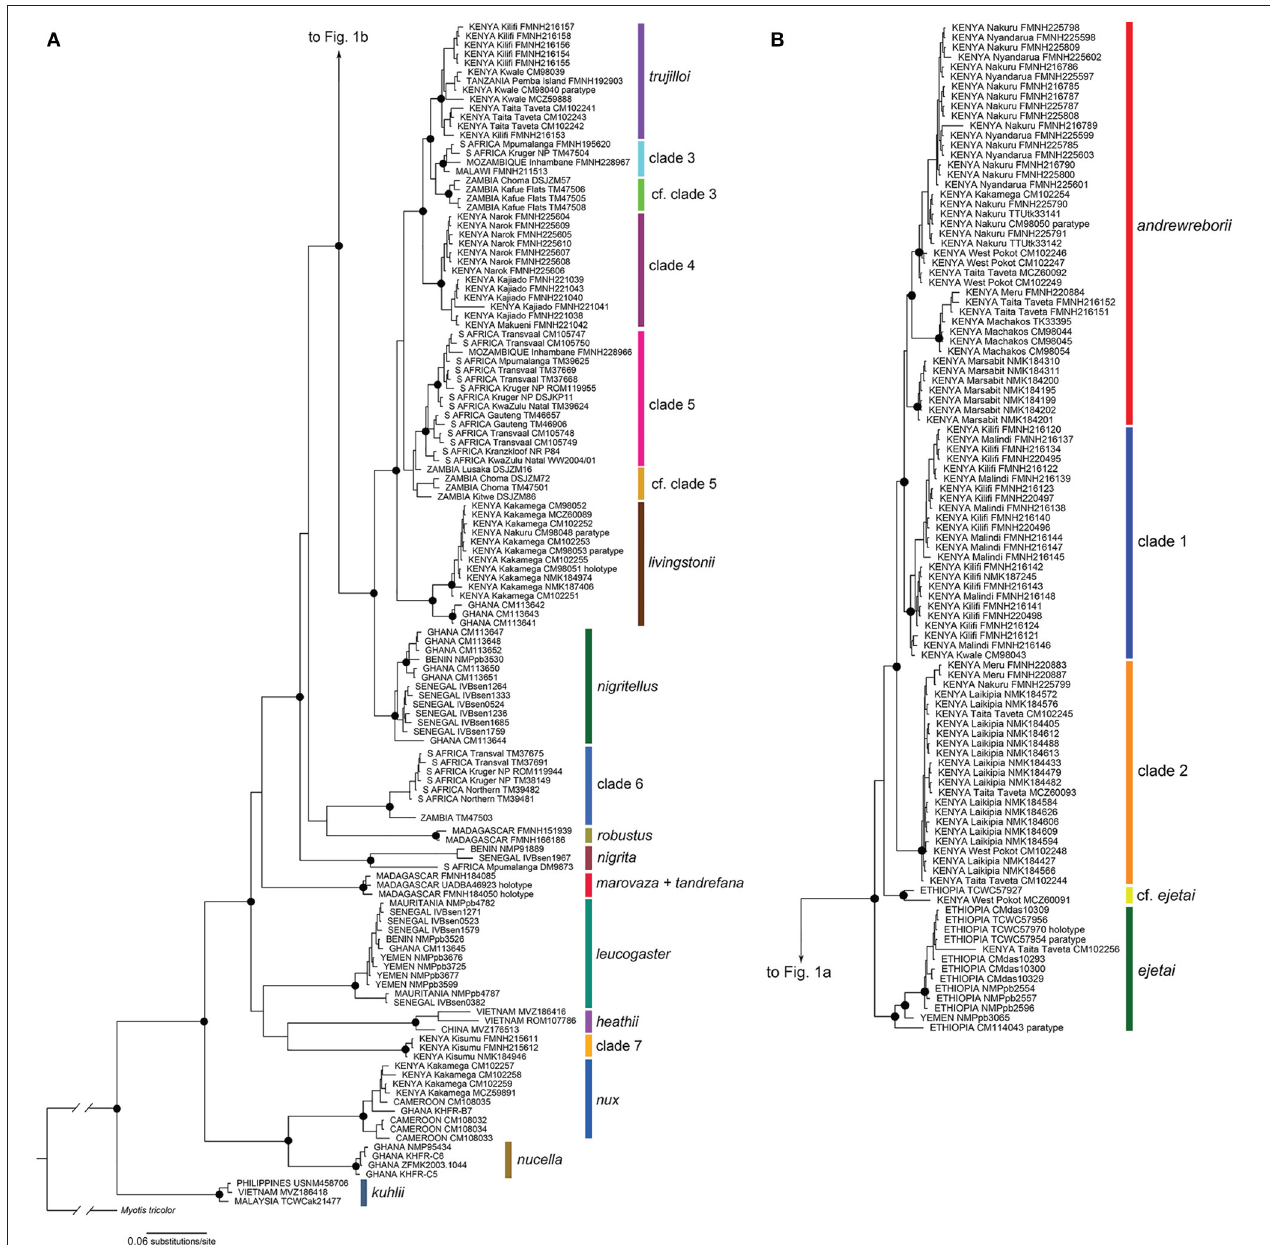
FIGURE 1 | Bayesian phylogeny of mitochondrial cytochrome b sequences of Scotophilus (A) continued on (B) . The phylogeny was inferred in MrBayes and its topology was very similar to the maximum likelihood phylogeny calculated in RAxML. Filled circles on nodes denote Bayesian posterior probabilities ≥ 95% and ML bootstrap values ≥ 70%. Support values at nodes for most minor clades not shown. Specimen localities include counties for Kenya and provinces for South Africa. Museum acronyms are defined in Appendix 1, Supplemental Material. trees because only 11 of 21 species/clades were